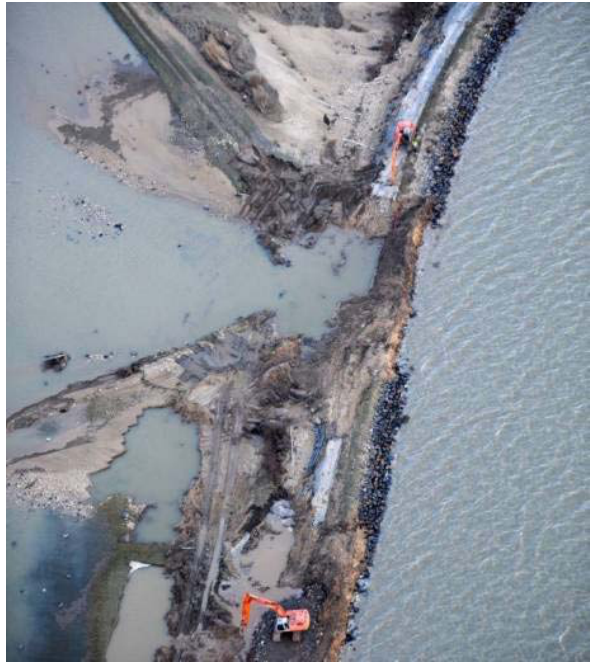
Fig 1. Area flooded and the loss of life in east England as a result of the 1953 coastal floods. (Sources: Steers, 1953; Summers, 1978; and Baxter, 2005).